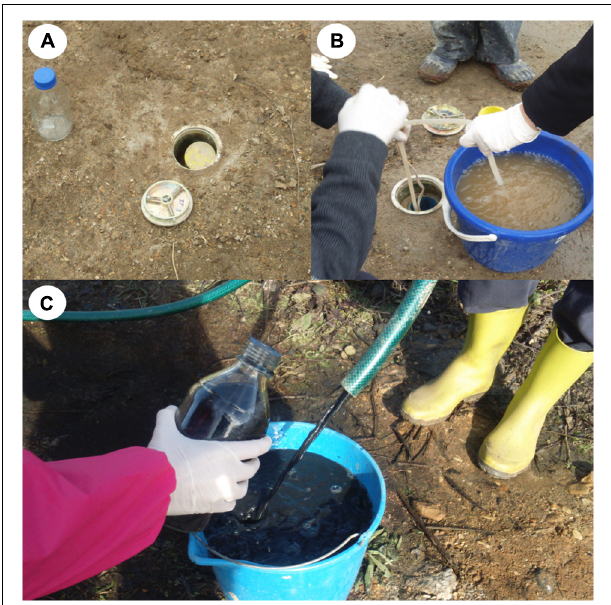
FIGURE 2 | (A) Monitoring well excavated in the land. (B) Groundwater purged from a well. (C) groundwater with nZVI (appearing as a black suspension) collected after